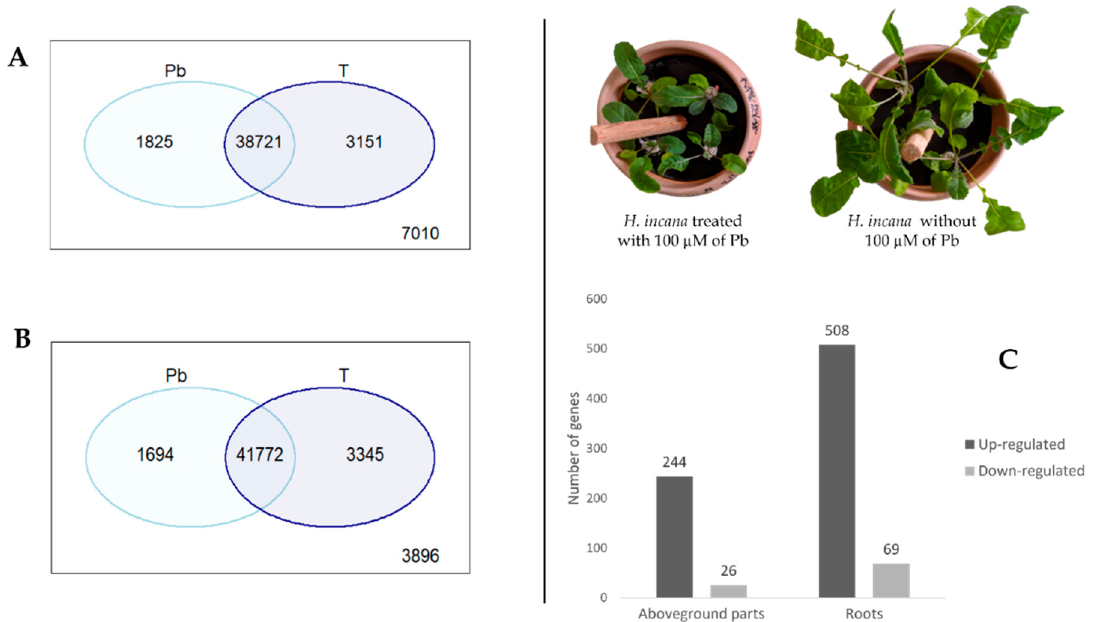
Figure 3. Venn diagram and DEGs in roots and aboveground parts of H. incana : ( A ) Venn diagram for control (T) and treated (Pb) in aboveground parts; ( B ) Venn diagram for control (T) and treated (Pb) in roots; and ( C ) number of DEGs in different tissues.